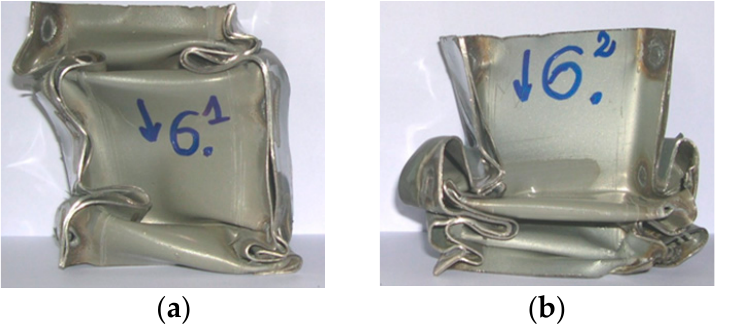
Figure 11. Specimens after the dynamic buckling experiments: specimen without broken spot-welded joints ( a ); specimen with two broken spot-welded joints ( b ).